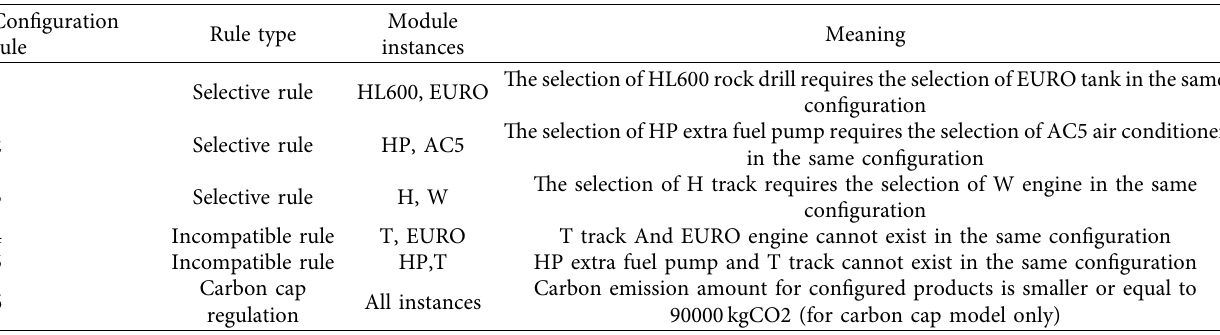
Figure 5: Structure of a configurable ranger-drilling machine. Table 2: Configuration rules.